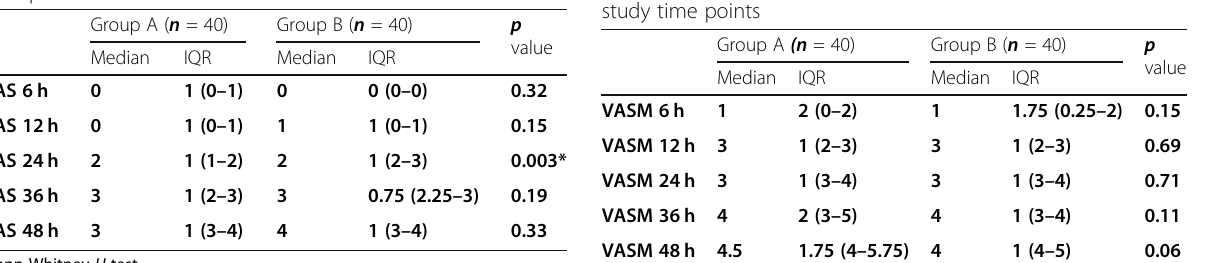
Table 4 VAS in the two study groups at rest at different study